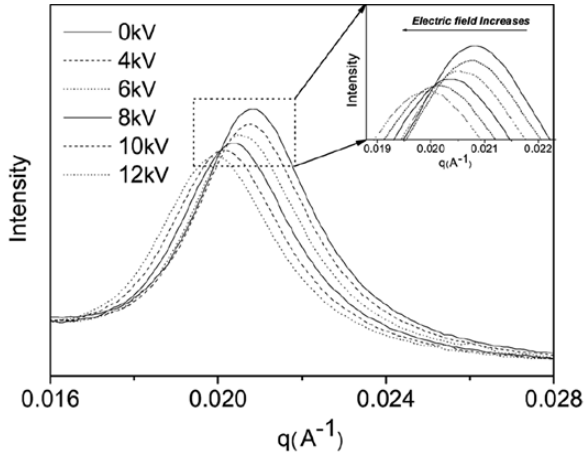
Figure 17: SAXS patterns of the SEBS gel as a function of the applied electric field